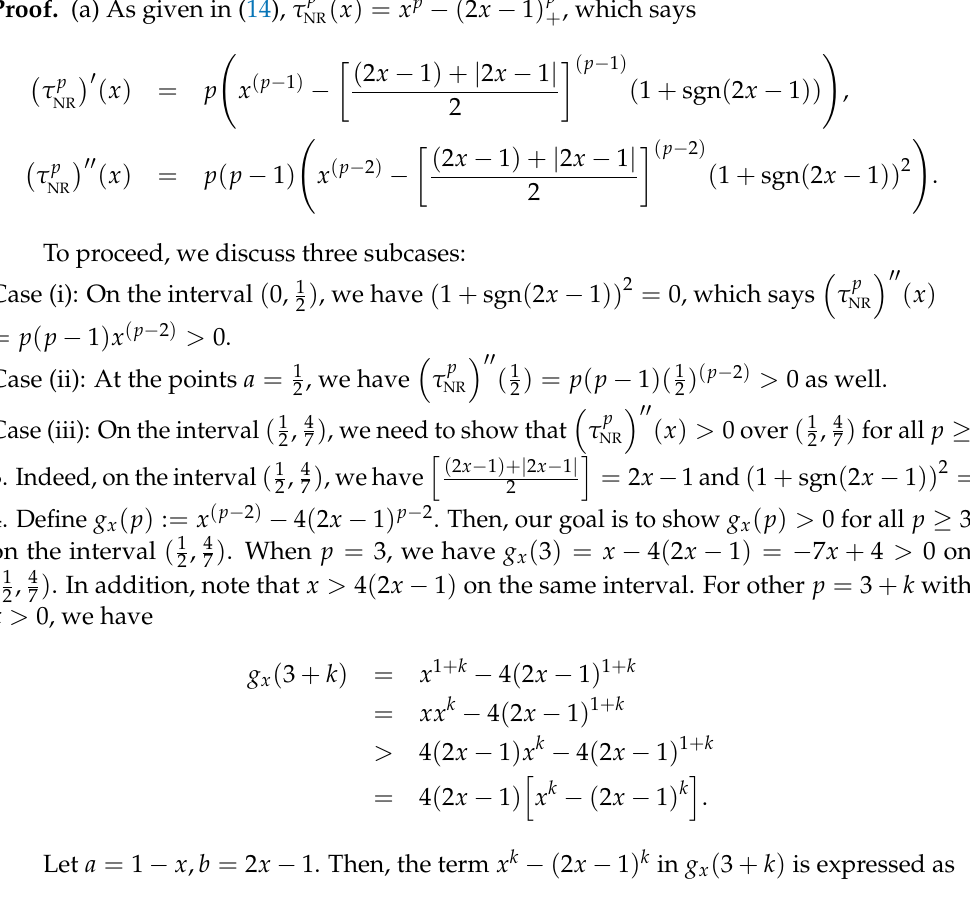
and τ p with different values of p . ( a ) Graphs of τ p NR S − NR with different values of p S − NR